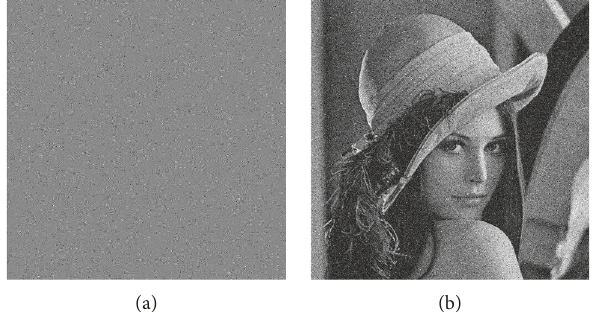
Figure 10: Effect of noise attacks with β � 15. (a) Encrypted image with noises. (b) Decrypted image.